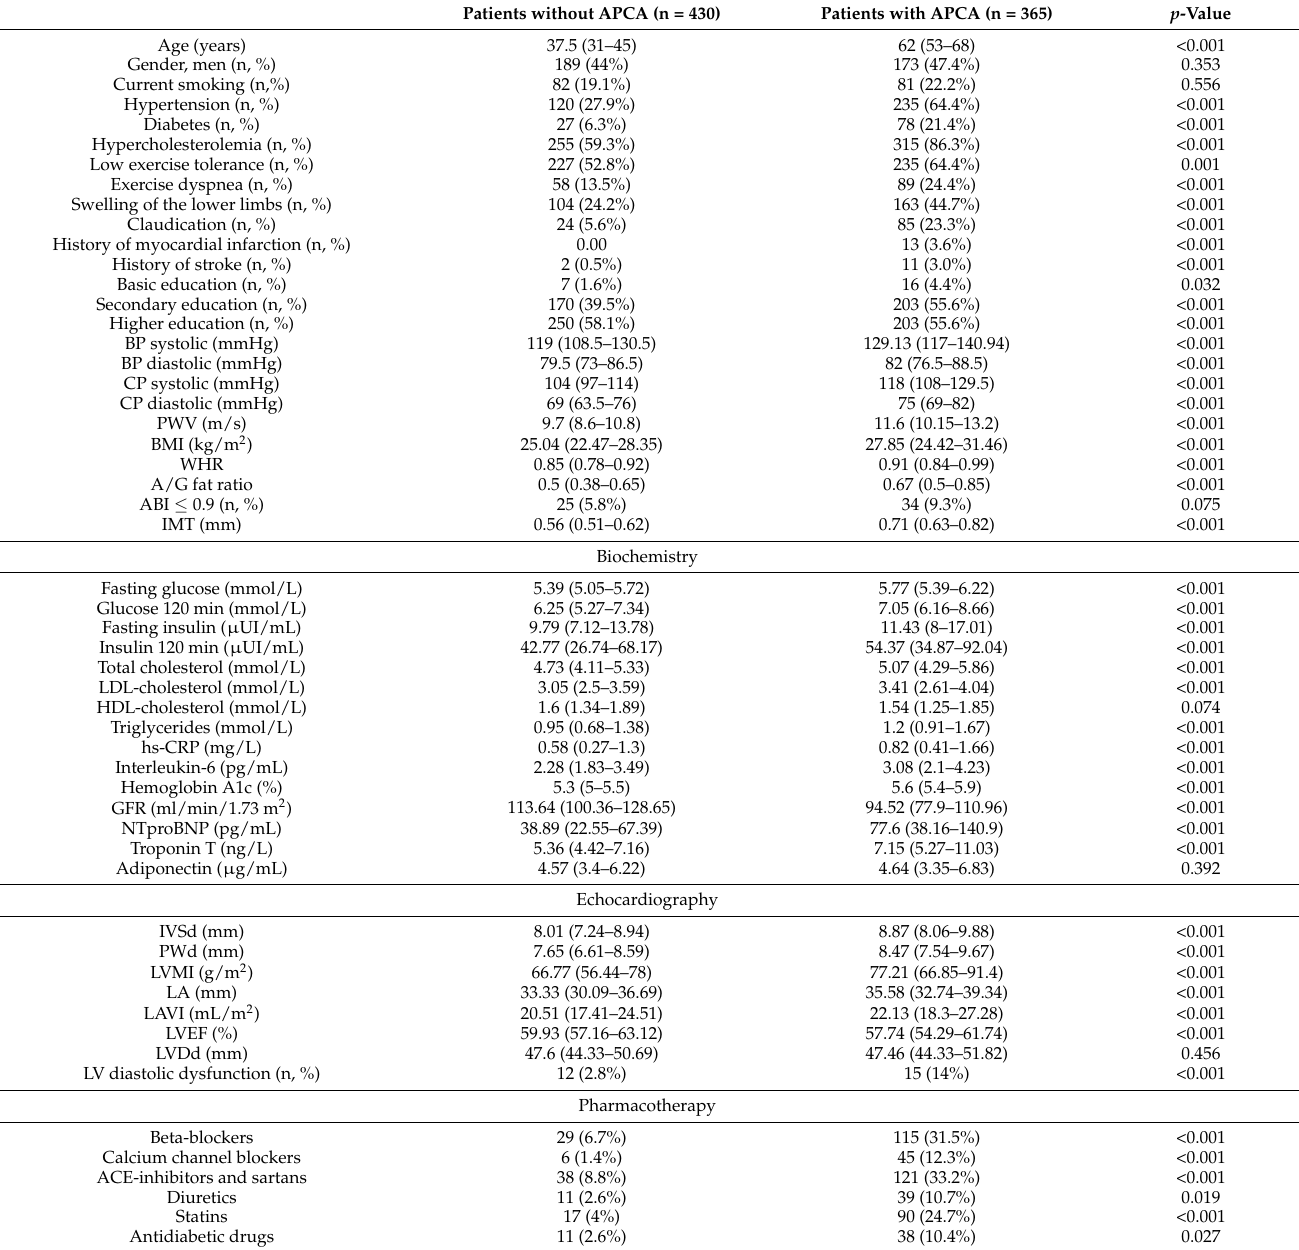
Table 2. Characteristics of the study group depending on the presence of atherosclerotic plaques in carotid arteries